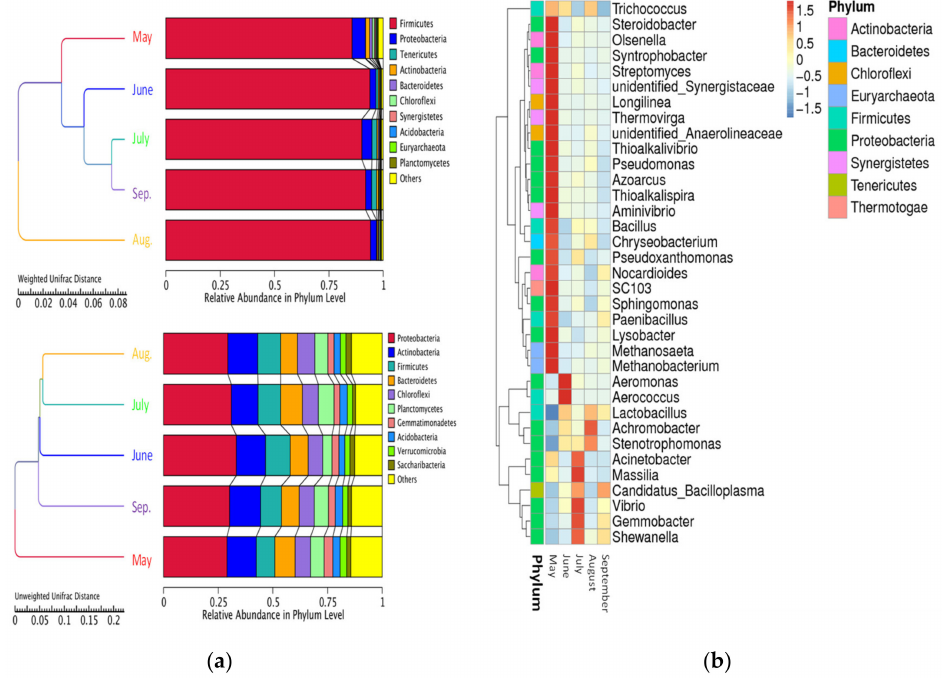
Figure 1. ( a ) Unweighted pair–group method with arithmetic means cluster tree based on unweighted and weighted unifrac distance. This was displayed with the integration of clustering results and the relative abundance of each sample by phylum. ( b ) The top 10 taxa at the genus level were selected to form the distribution histogram of relative